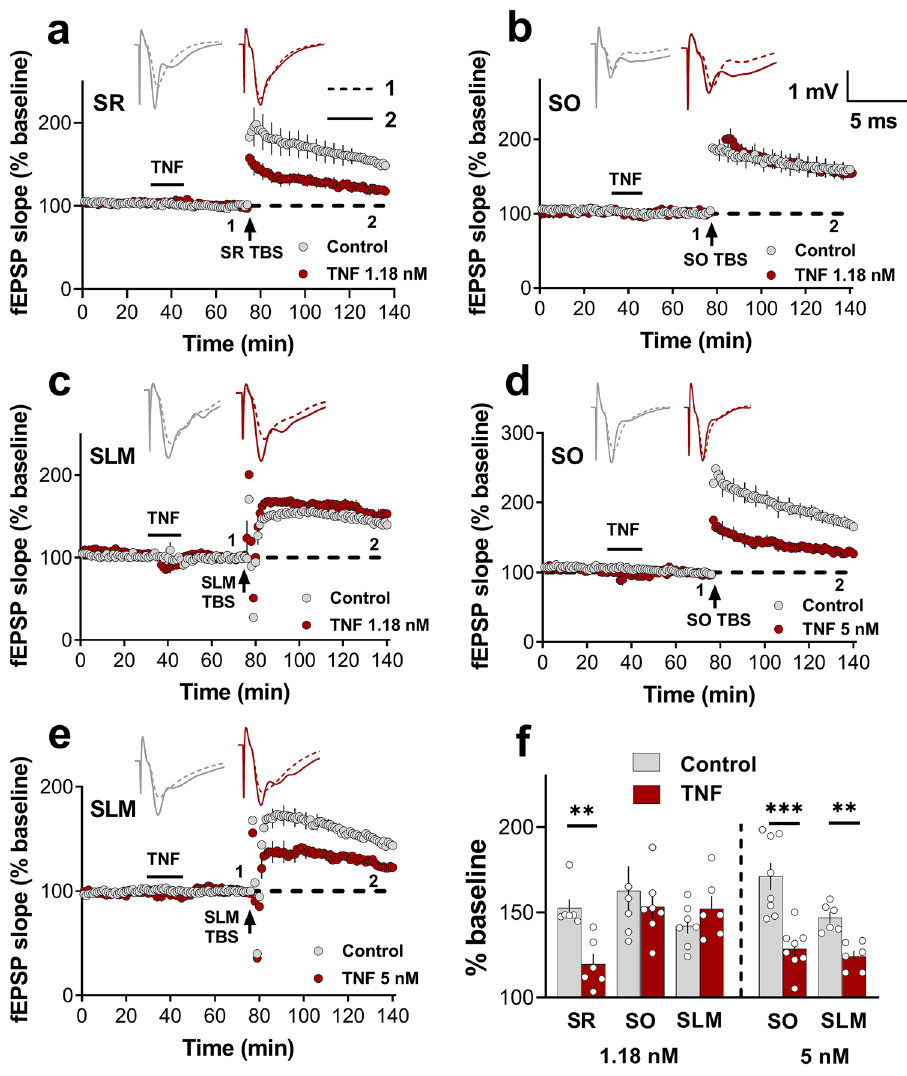
Figure 3. Pathway specificity of TNF priming. ( a ) Bath application of 1.18 TNF (bar) inhibited SR LTP (Control = 152.6 ± 7%, n = 6; TNF = 119.6 ± 5%, n = 6; t (10) = 4.24, p = 0.001). ( b ) Bath application of TNF had no effect on SO LTP (Control = 165.1 ± 8%, n = 9; TNF = 153.3 ± 7%, n = 7; t (14) = 0.90, p = 0.37), or ( c ) SLM LTP (Control = 154.7.1 ± 8%, n = 6; TNF = 152.2 ± 6%, n = 6; t (10) = 0.26, p = 0.79). ( d ) At 5 nM, bath application of TNF inhibited SO LTP (Control = 171.1 ± 12%, n = 8; TNF = 128.6 ± 9%, n = 8; t (14) = 4.61, p = 0.0004), and ( e ) SLM LTP (Control = 148 ± 7%, n = 8; TNF = 124.3 ± 4%, n = 5; t (9) = 4.33, p = 0.001). ( f ) Bar graph summarising